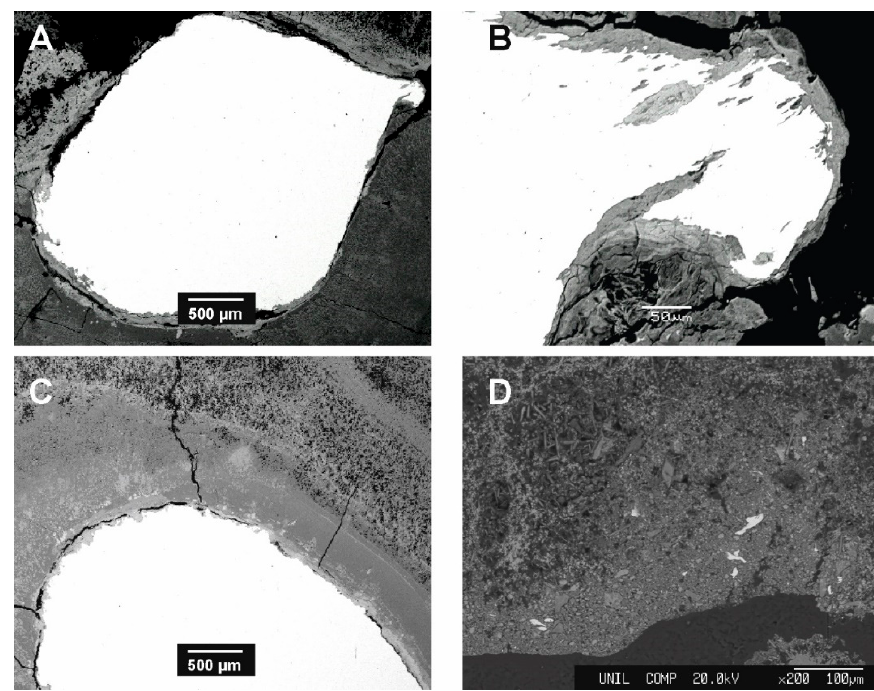
Figure 3. SEM photomicrographs: ( A ) Native iron nodule; ( B ) Oxidations were identified only at the external surface of the grains, as a result of their exposure to atmospheric conditions and water during their transfer and until their entrapment inside the travertine; ( C ) The travertine laminae around the nodules are not interrupted, but were developed around the nodules, suggesting that the nodules were placed simultaneously with the creation of the travertine; ( D ) Several smaller angular pieces of native iron were found inside the travertine (from few μ m up to tens of μ m).